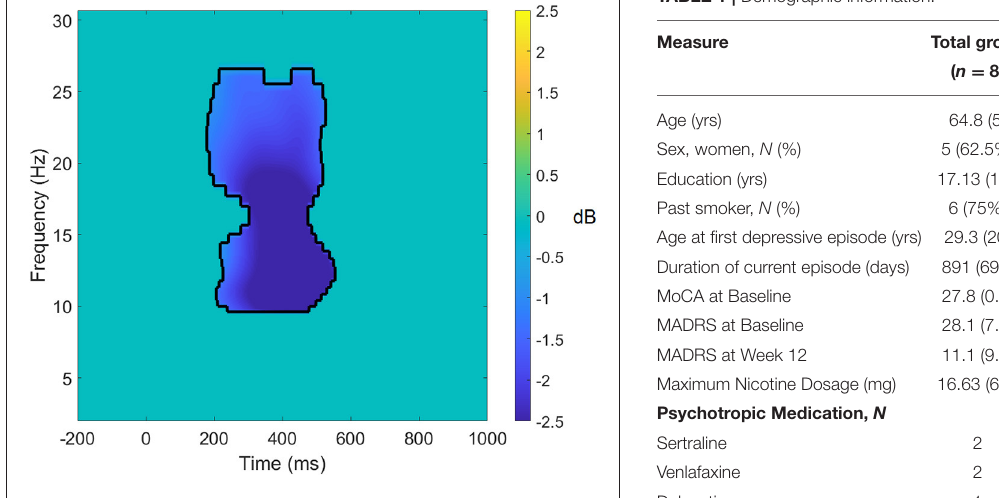
FIGURE 1 | Significant target average data for the parietal cluster for the auditory oddball task. Data within the black lines represent frequency × time points that remain significant following false discovery rate correction of p < 0.01. All other data that does not survive the correction has been set to 0. Power differences are in